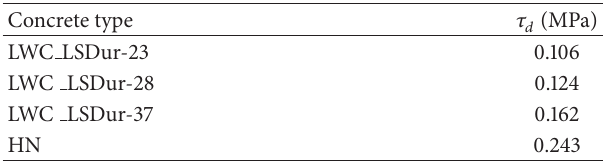
Table 4: Values of equivalent shear stress obtained in pull-out tests.